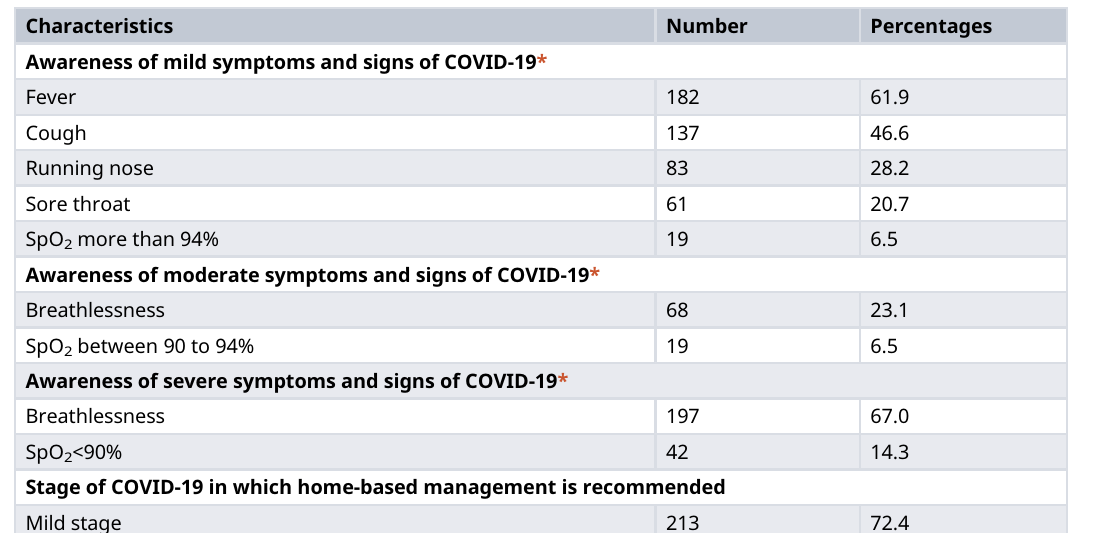
Table 4. Awareness of COVID-19 among the